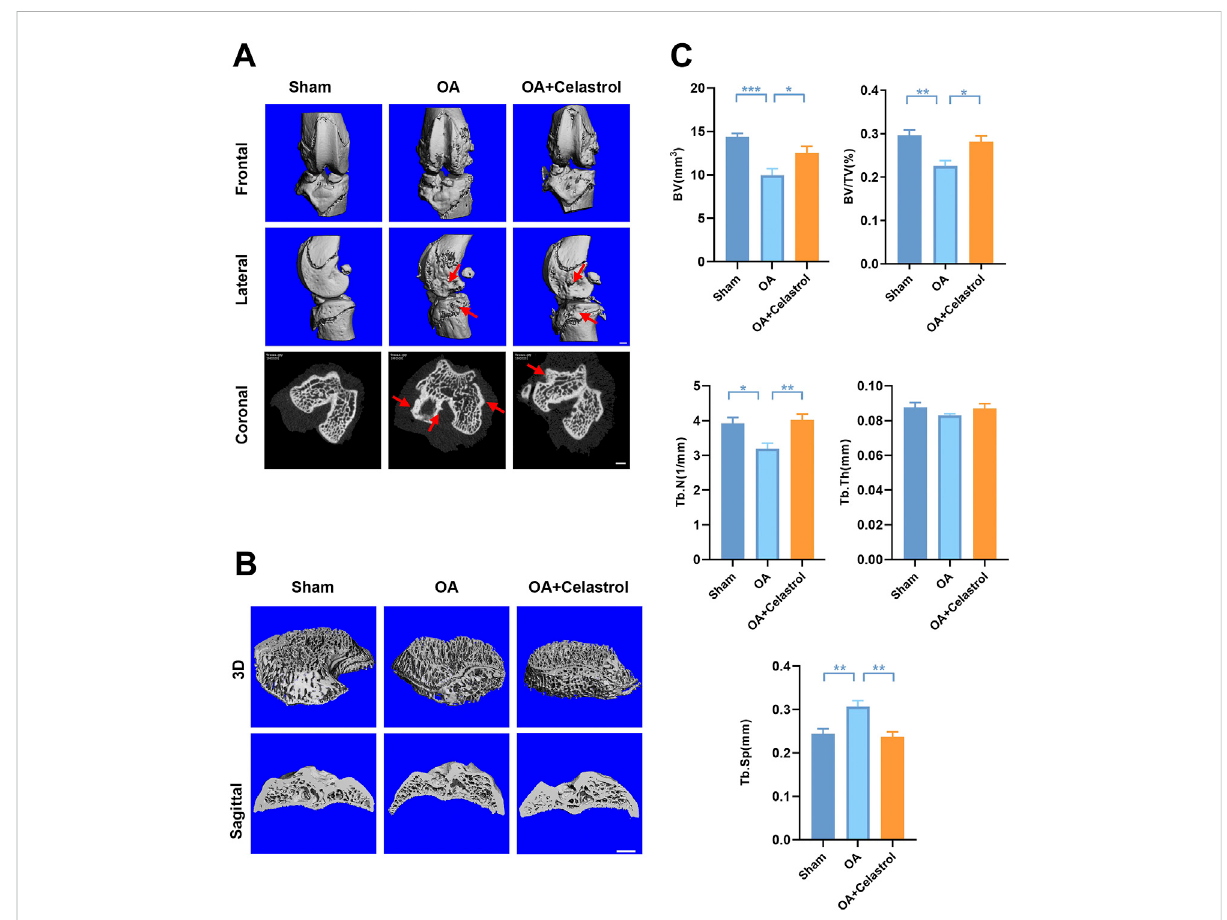
FIGURE 2 Celastrolreducedosteophyteformationandboneresorption inducedbyMCLT+pMMT invivo . (A) Representative μ CTimagesoffrontal,lateral andcoronalviewsofthekneejoints fromdifferentgroups (scalebar:1 mm). (B) Representative three-dimensional μ CTimagesofsubchondral bone andsagittalviewsofmedialcompartmentsubchondralbone(scalebar:1 mm). (C) QuantitativeanalysisofBV,BV/TV,Tb.NTb.ThandTb.Sp,n=6.All data represent mean ± S.E.M. * p < 0.05, ** p < 0.01 and *** p <